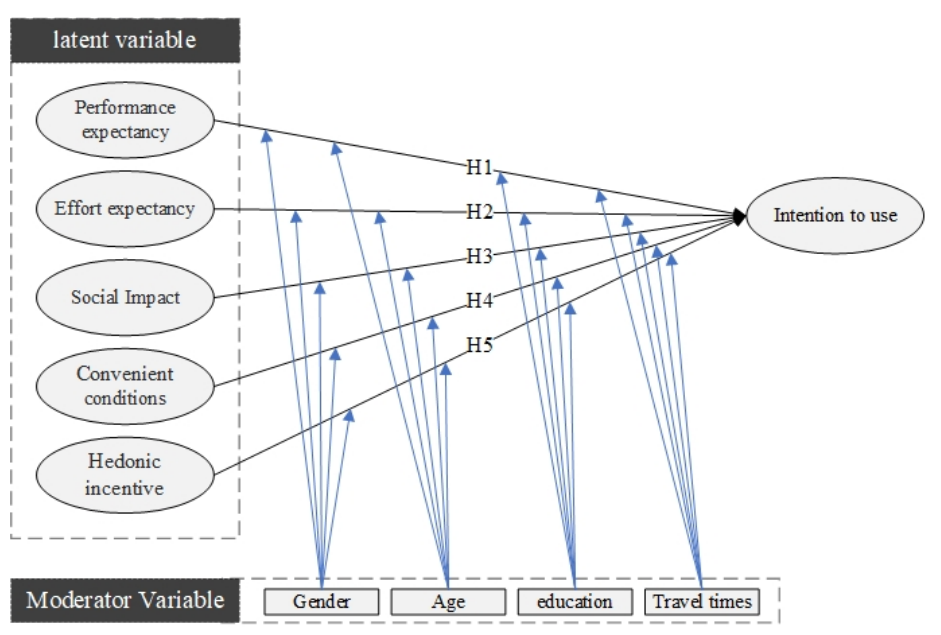
Figure 12. Research